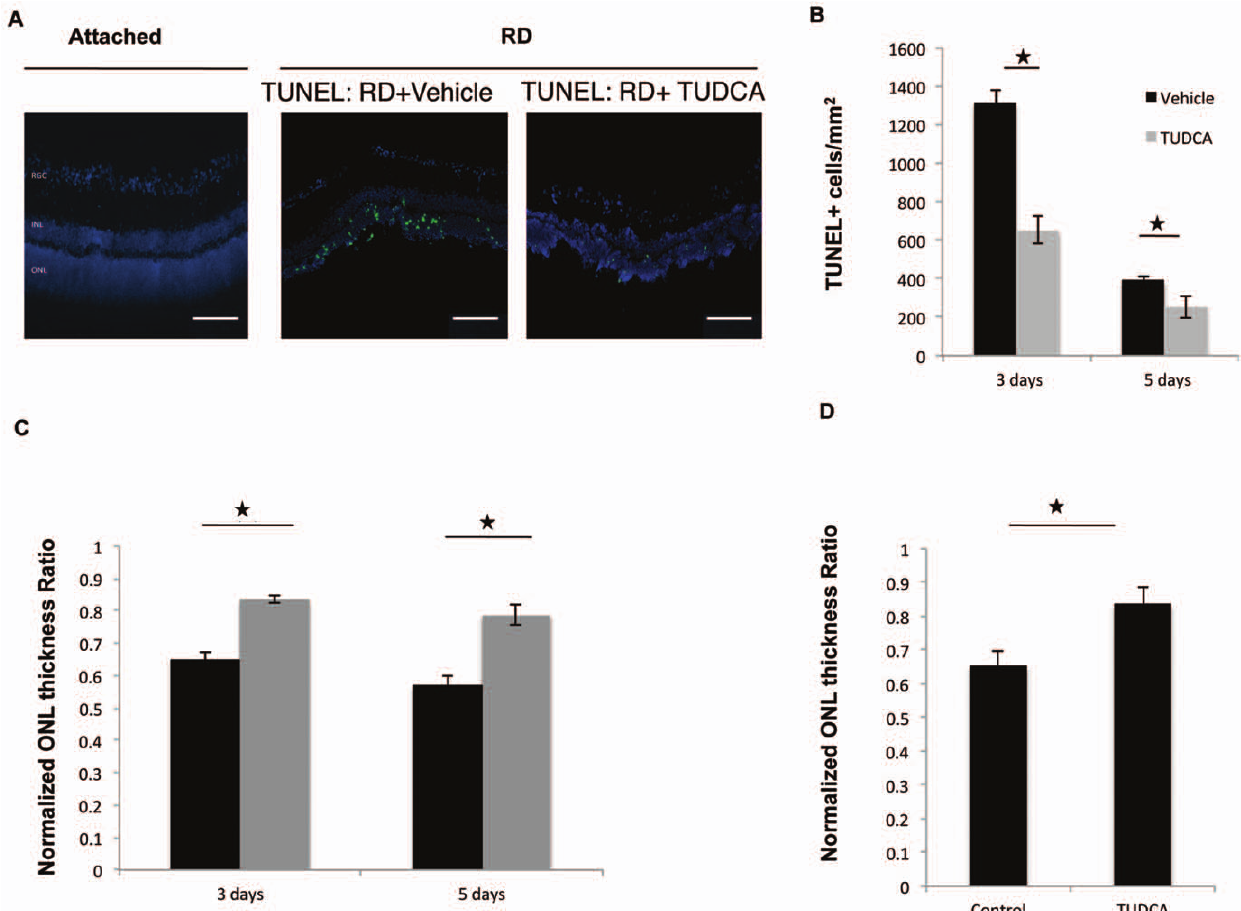
Figure 1. Systemic TUDCA administraton decreases photoreceptor cell loss in RD . ( A ) DAPI (blue) and TUNEL (green) staining of attached or detached for 5 days retina sections. TUDCA treatment was started 24 hrs before RD induction and continued daily at a dose of 500 mg/kg/day. ( B ) Quantitative analysis of TUNEL positive cells 3 and 5 days after RD with or without daily TUDCA treatment (500 mg/kg/day, I.P.). (n=6, p , 0.05). ( C ) Quantitative data exhibiting the protective effect of TUDCA (500 mg/kg/day, I.P.) on ONL thickness preservation, 3 and 5 after RD. (n=6, p , 0.05). ( D) Protective effects of TUDCA were seen even when TUDCA treatment was started 6 hours after RD induction. (n=6, P , 0.05).